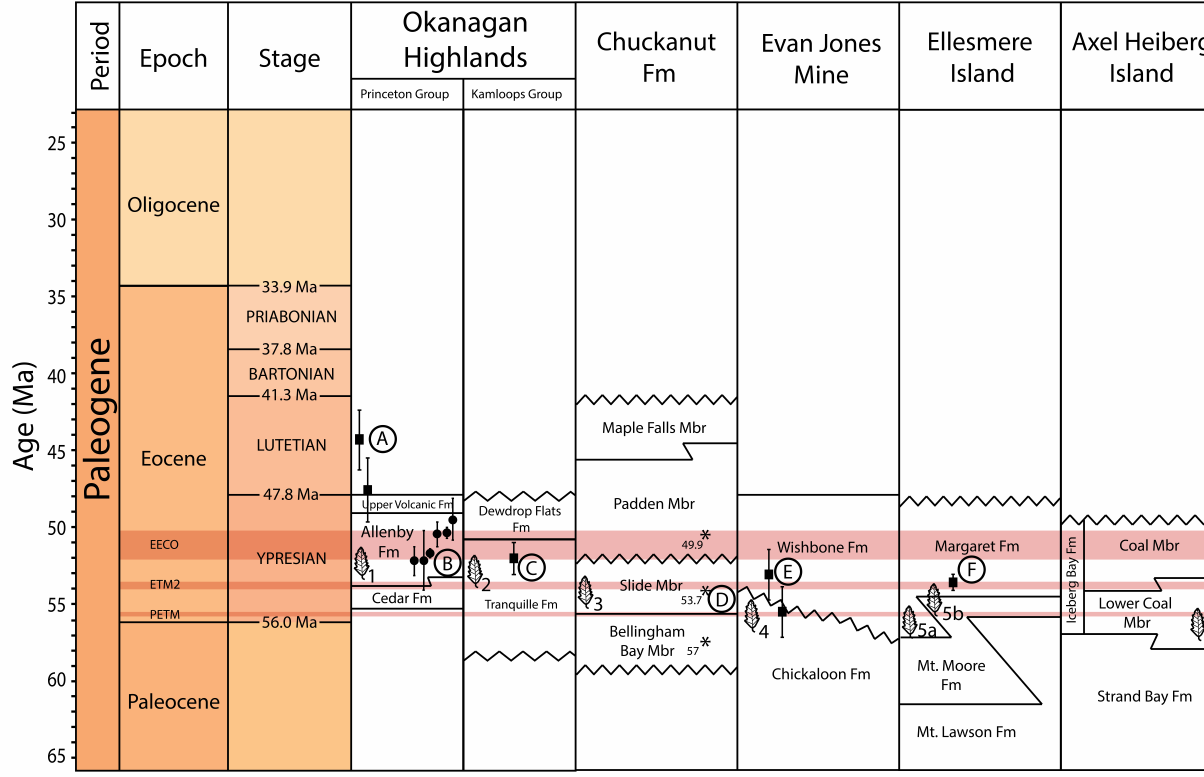
Figure 2. Stratigraphic compilation of corresponding formations for the fossil localities used in this study. A–F represent the corresponding radiometric data for those formations, and leaf images numbered 1–6 represent approximate stratigraphic positions of the floras used for this study. Fm: formation; Mbr: member. Data compiled from Sunderlin et al. (2011), Breedlovestrout et al. (2013), Greenwood et al. (2016), and West et al. (2015). Modified from West et al. (2019) and Greenwood et al.